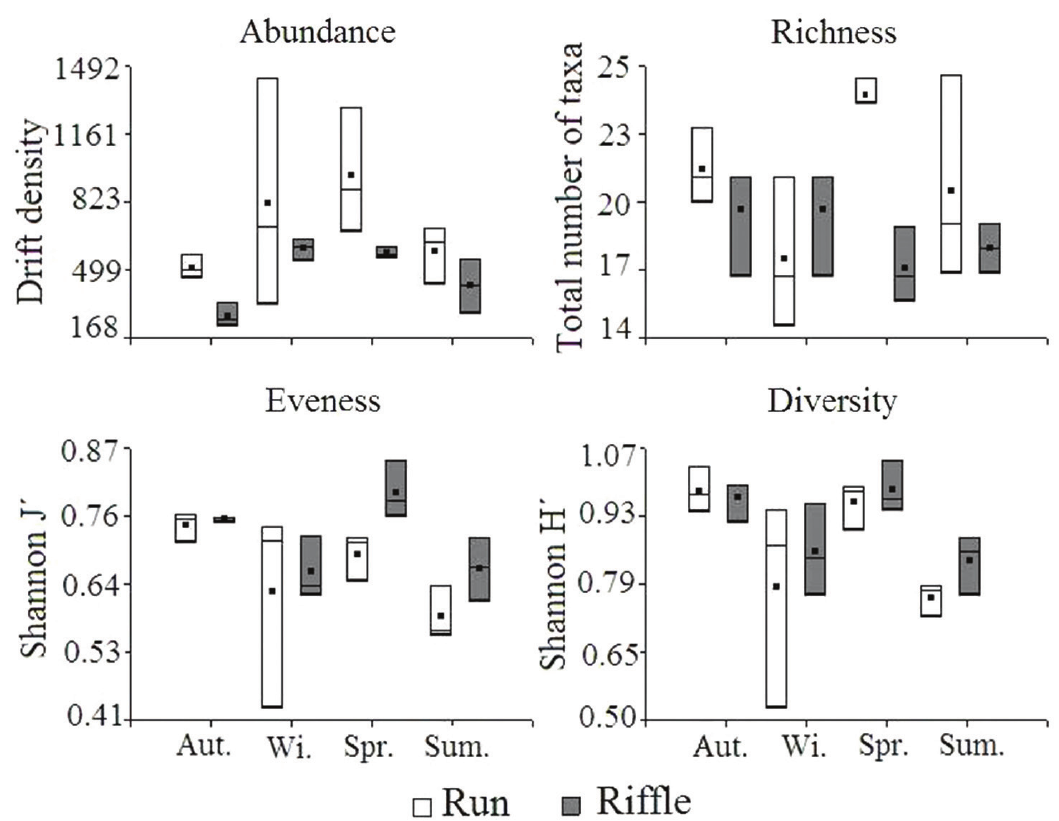
Figure 5. Box plots for macroinvertebrate drift abundance, taxonomic richness, diversity and evenness in run and riffle of the study site. Seasons: autumn (Aut.), winter (Wi.), spring (Spr.) and summer (Sum.).